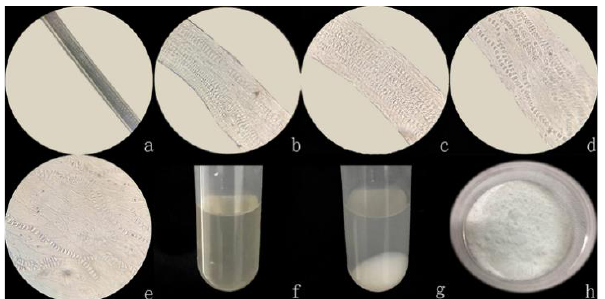
Figure 1. ( a – e ) Observation of the extraction process via light microscopy under different